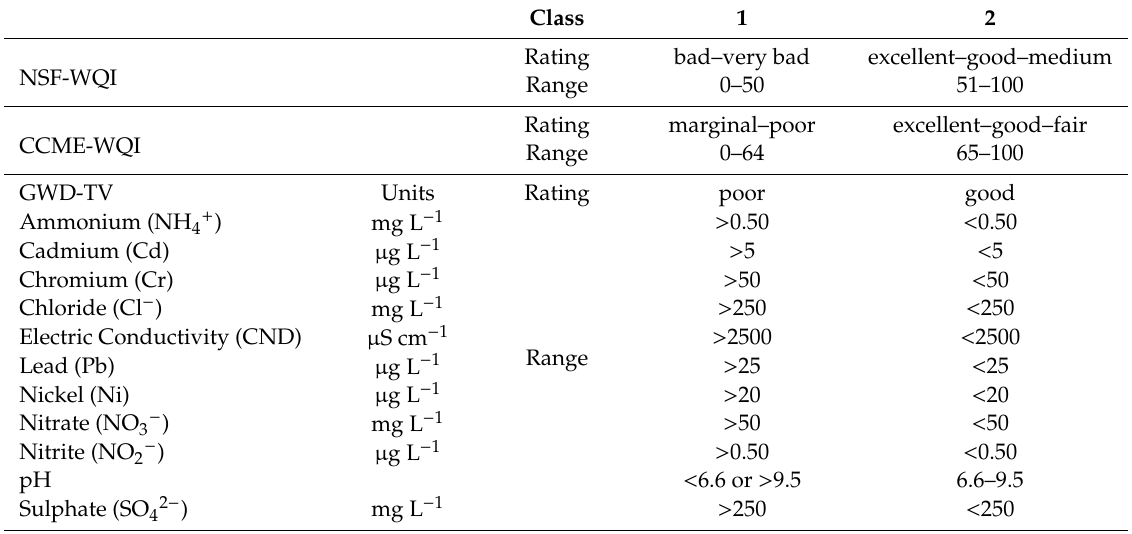
Table 2. Harmonization of WQIs to GWD-TV classes based on criteria given by NSF, CCME and